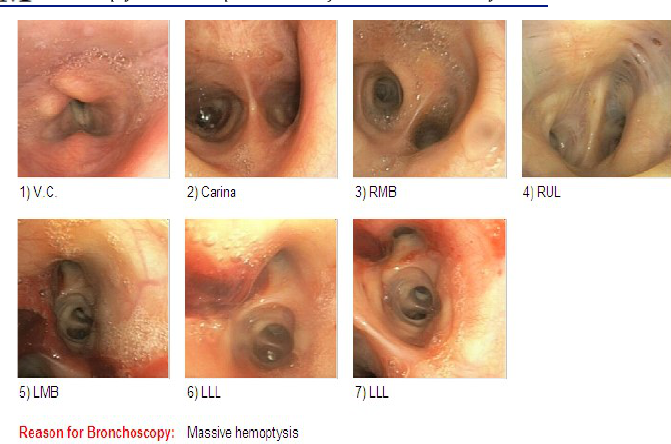
Figure 4 . Fiberoptic bronchoscopy